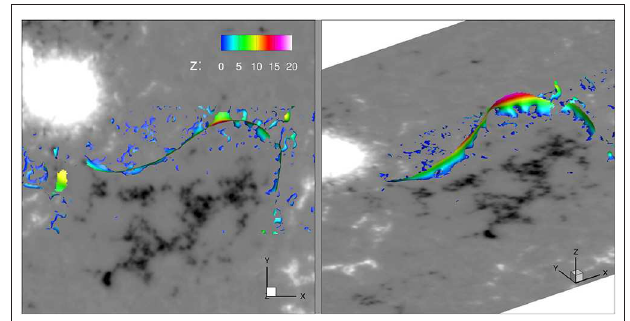
FIGURE 4 | Two different views of distribution of magnetic dips, which is shown by the colored structures, and the colors represent the heights of the dips.